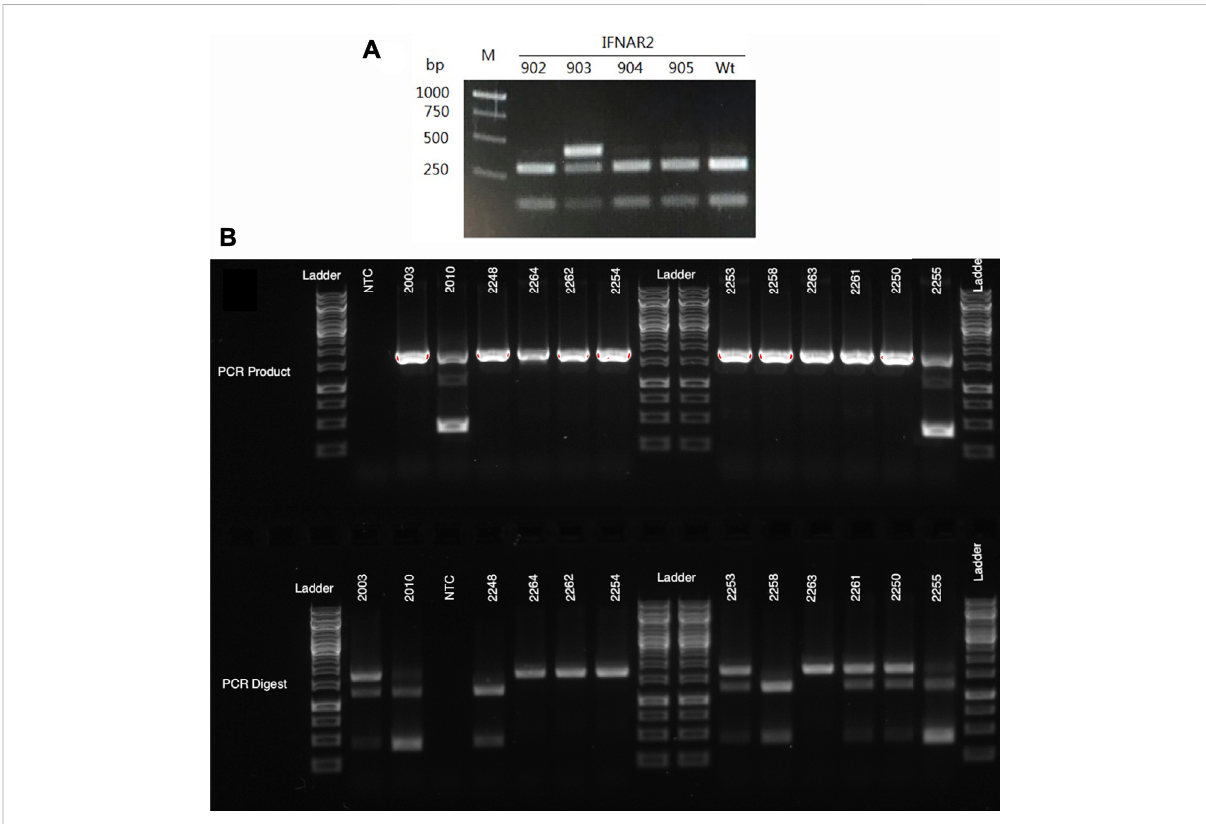
FIGURE 2 Genotyping gelsfor IFNAR2 knockoutsheep. (A) AnexampleoftheinitialPCR-RFLPtypingresultsforoffspringof7IFN2,an IFNAR2 − / − ram.PCR ampli fi cationwasdonewith primerscreated forscreeningtheknockoutcellcolonies thatamplifya418bpsegment ofthegene.Sincethesire wasa biallelicknockoutandthedamswereWTRomneys,thelambswereallexpectedtohaveoneWTandoneknockoutallele.However,threeofthefour lambs (IFN902, 904 and 905) appeared to only have the WT allele, which is cut by the restriction enzyme NcoI. In contrast, lamb IFN903 had both a WT and an uncut allele with the previously identi fi ed 5 bp deletion. These results suggested that the sire carried a second IFNAR2 knockout allele with a large deletion. (B) The top gel shows PCR ampli fi cation of genomic DNA with primers that amplify a 1,706 bp segment of the IFNAR2 gene. Two of the sheep on this gel, IFN2010 and IFN2255, have a large 1,282 bp deletion, resulting in a much smaller 424 bp amplicon. The bottom gel shows the PCR products following digestion with NcoI. The WT allele, which is cut by NcoI, appears as two bands of 1,259 and 447 bp. The knockout allele with a small 6 bp deletion remains uncut and is seen as a 1,701 bp